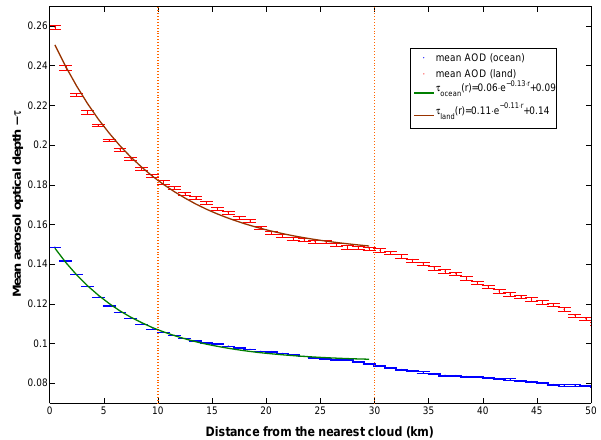
Fig. 5. Global mean aerosol optical depth (AOD) as a function of the distance from the nearest cloud, retrieved above land (red dots) and above ocean (blue dots), and the matching exponential fitting functions (purple and green lines, respectively), for distances of 0– 30km from the nearest cloud. The error bars represent the standard mean error. All data are based on MODIS Terra observation for 28 July 2008. The constant distance lines highlight the values for R 0 = 10km and for the calculated global characteristic value ( R 0 = 30km, see Sect.